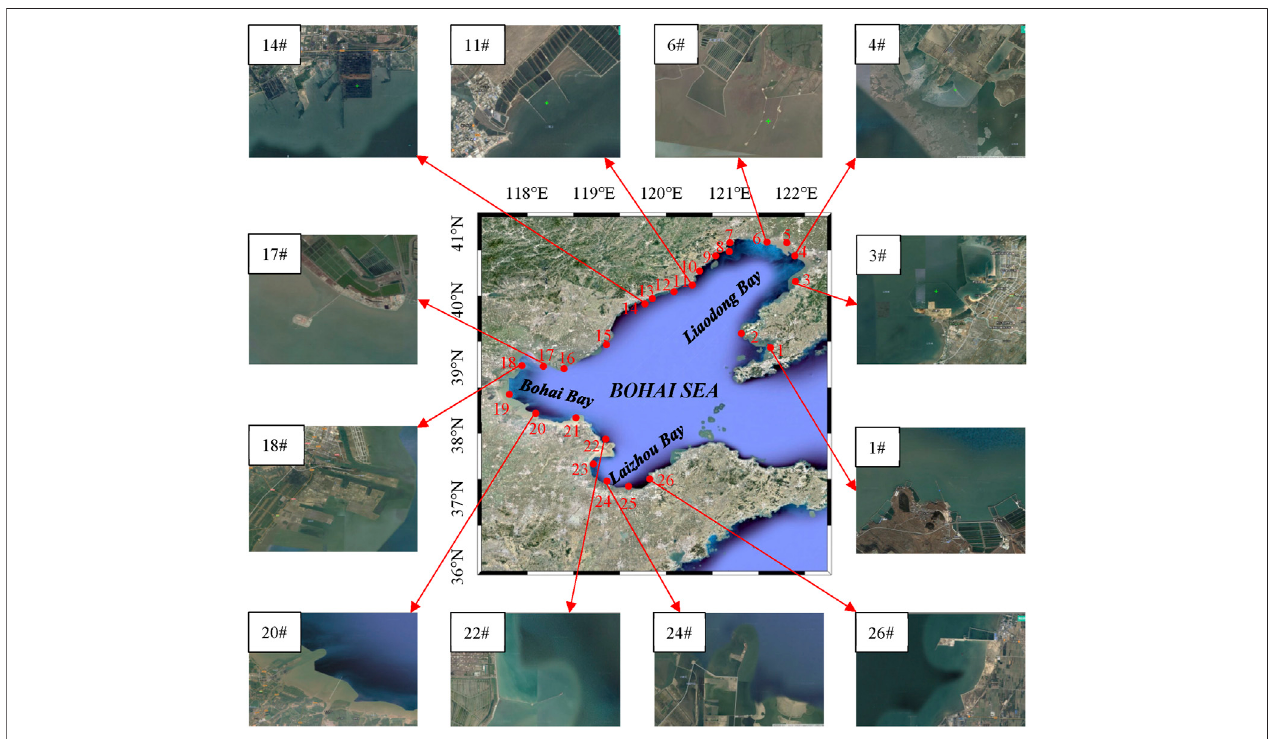
FIGURE 2 | Positions of the 26 sites selected as coastal base points in the Bohai Sea (red circles). The red number is the site number. Also shown are satellite images of some of these sites.